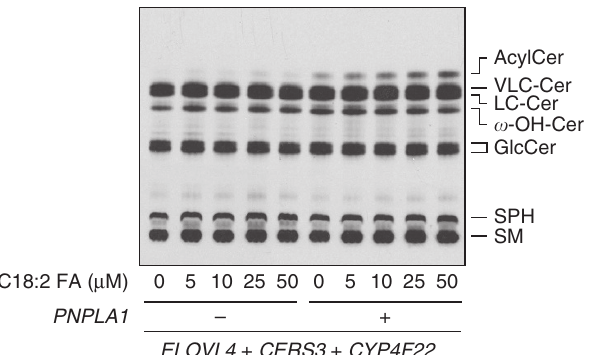
Figure 4 | Linoleic acid concentration-dependent acylceramide production by PNPLA1. HEK 293T cells were transfected with an empty vector or the plasmid encoding 3xFLAG-PNPLA , together with the plasmids encoding 3xFLAG-ELOVL4 , 3xFLAG-CERS3 and 3xFLAG-CYP4F22 . Twenty- four hours after transfection, cells were treated with the indicated concentration of linoleic acid and labelled with [ 3 H]sphingosine for 6h at 37 (cid:2) C. Lipids were extracted, separated by normal-phase TLC and detected by autoradiography. 18:2 FA, linoleic acid; AcylCer, acylceramide; Cer, ceramide; GlcCer, glucosylceramide; SM, sphingomyelin; SPH, sphingosine; o -OH-Cer, ULC o -hydroxyceramide. Four independent experiments gave similar results, and a representative result is